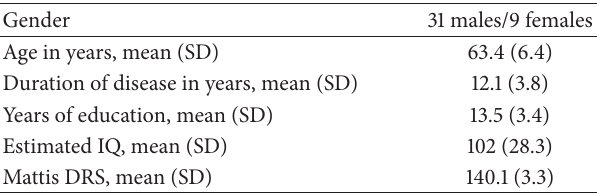
Table 1: Demographic and disease characteristics of PD patients by the time of inclusion. IQ-score was estimated from the Wechsler Abbreviated Scale of Intelligence